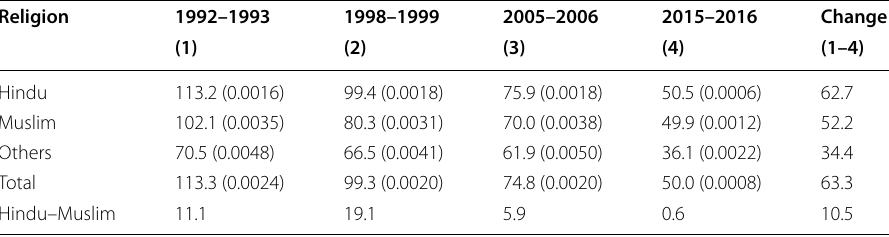
Standard Errors are reported in parenthesis; Estimates are based on the last births